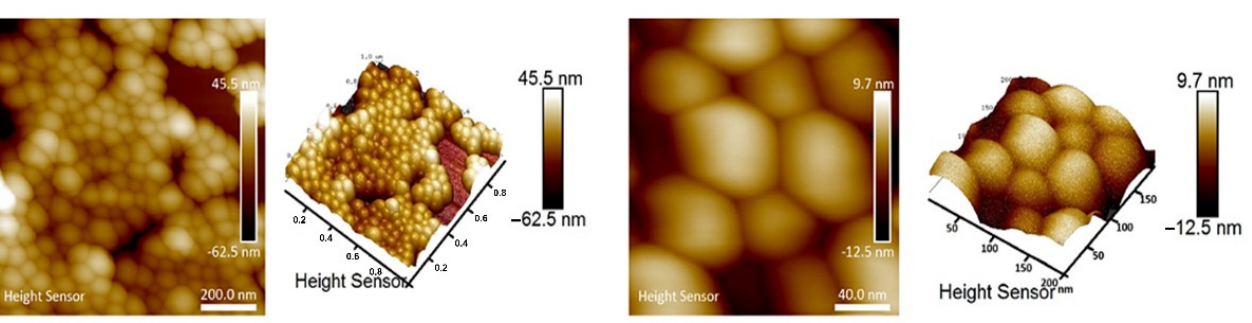
Figure 2. AFM images of synthesized SiO 2 NPs as 2D and 3D presentations at different magnifications.